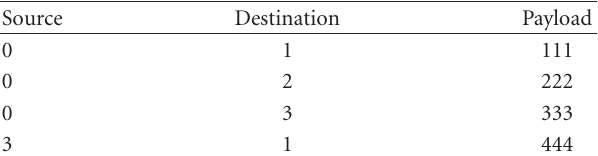
Table 21: Intermediate SE information while data moves from